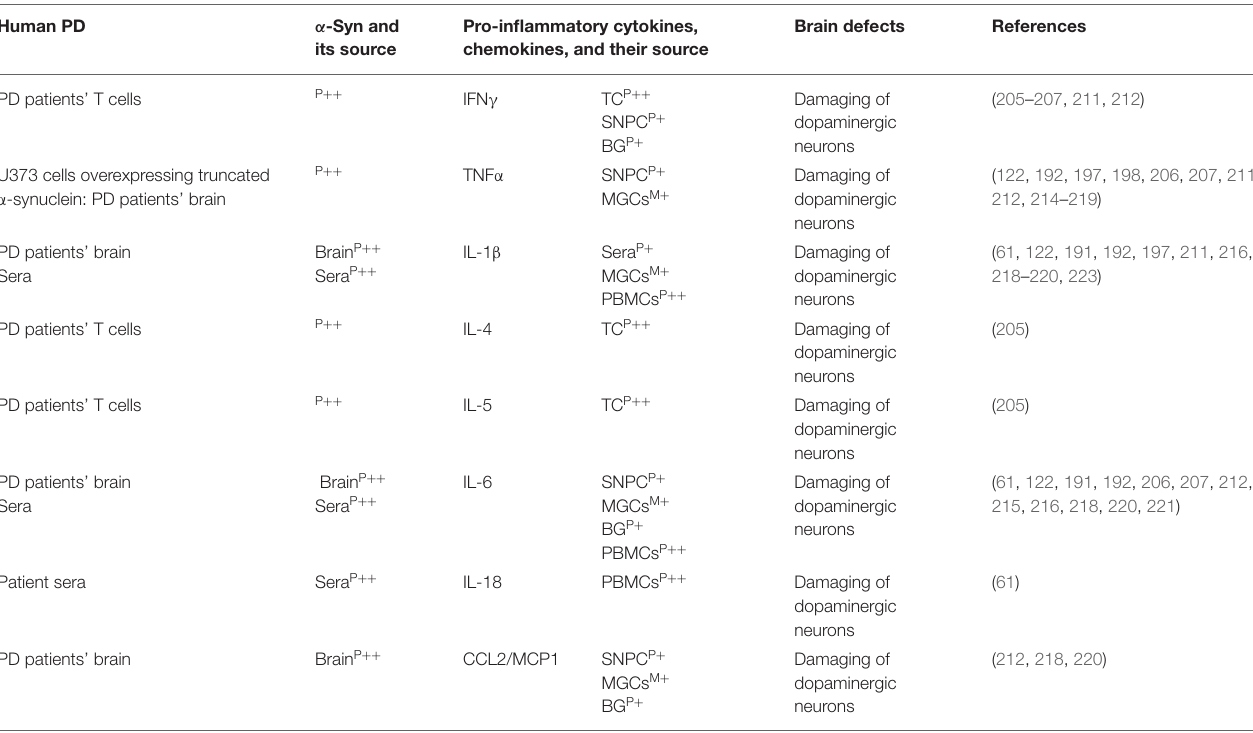
TABLE 4B | Cytokines and their source in the SNCA-associated human